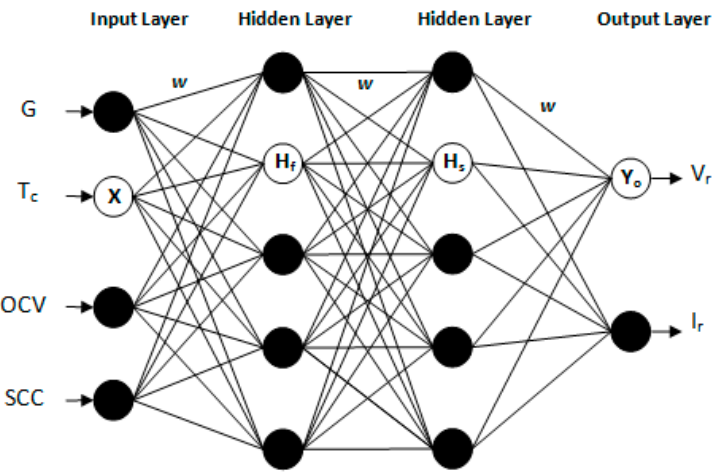
Figure 2. The developed deep feed-forward (DFF) network topology.